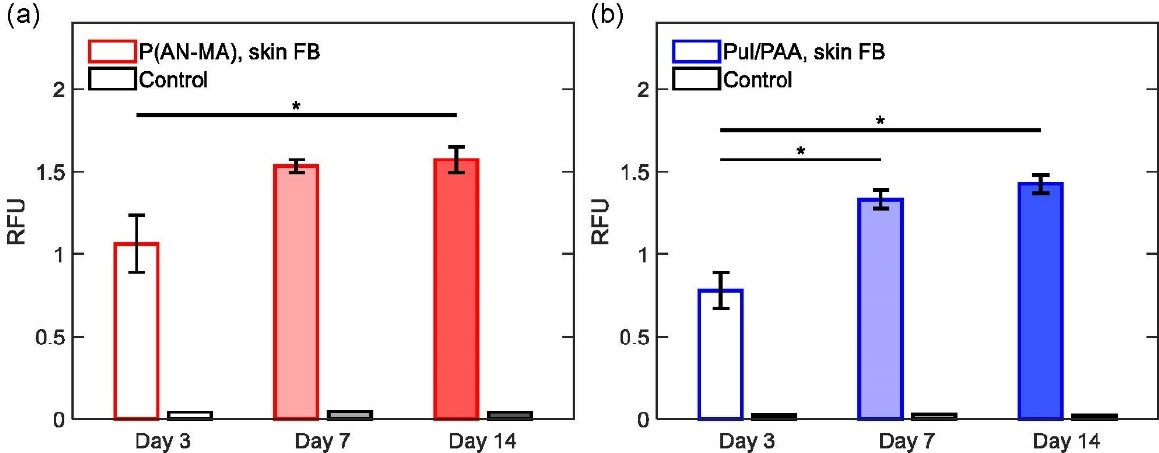
Figure 4. Metabolic assay of skin FBs ( n = 3) growing on electrospun nanofiber mats for 14 days analyzed by PrestoBlue HS Cell Viability Assay and control (electrospun nanofiber mats without cells). The mean of the fluorescence intensity shown as RFU of three scaffolds per condition with three measurements per sample were examined. Significant proliferation was found from day 3 to 14 on P(AN-MA) ( a ) and from day 3 to 7 and 14 for Pul/PAA ( b ). Significance p < 0.05 (*).